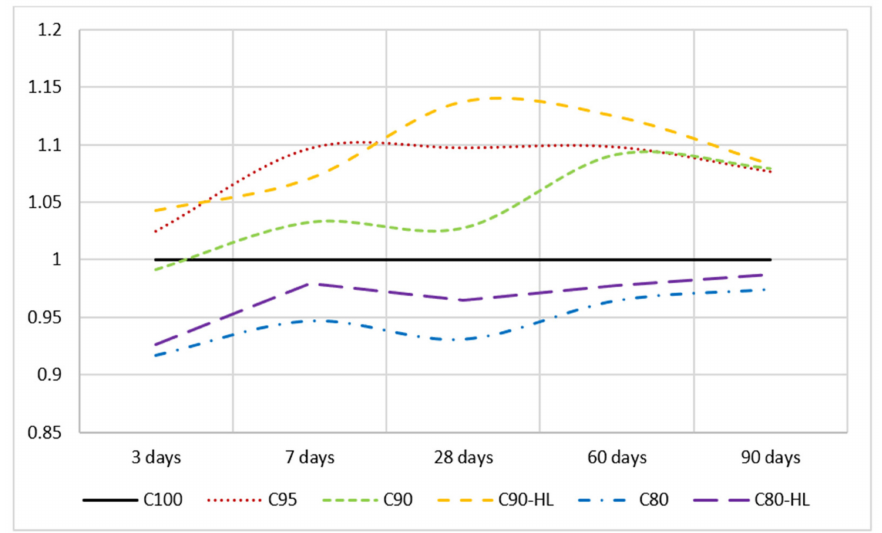
Figure 13. Relative strength index of self-compacting paste formulations at various waste burnt brick powder contents.